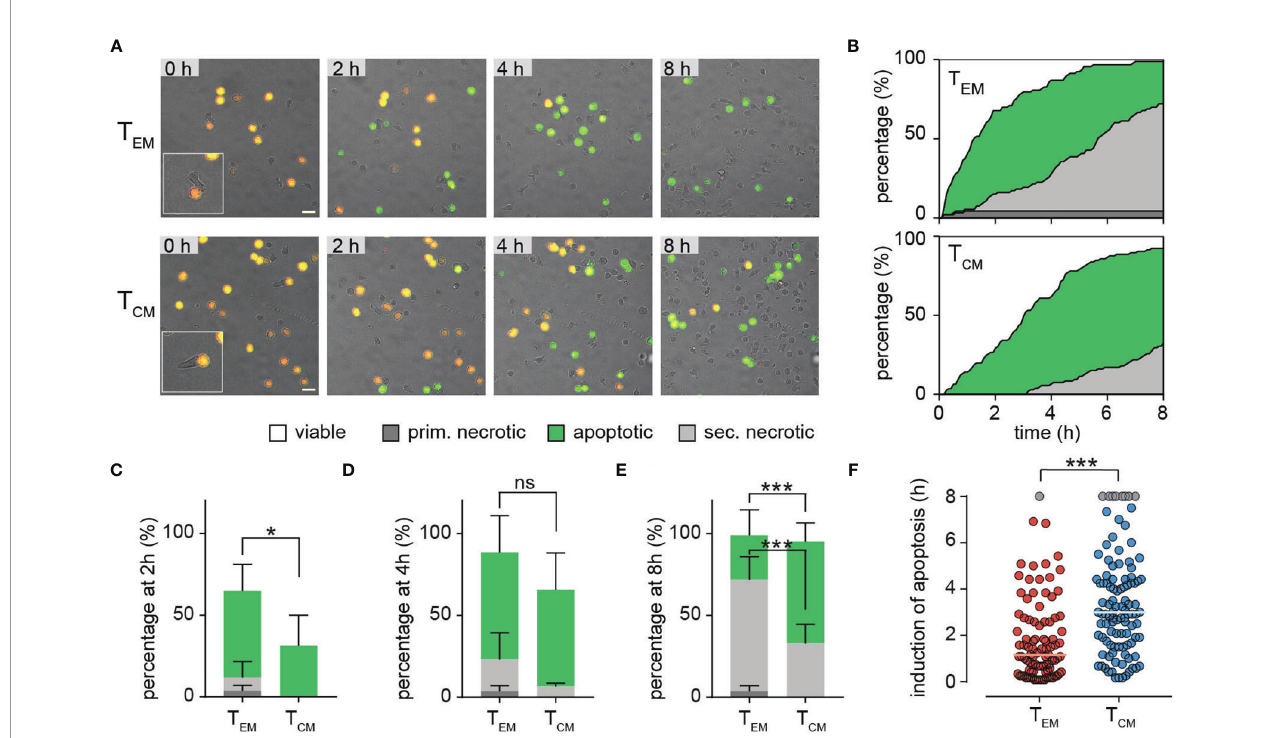
FIGURE 5 | Single cell level T EM and T CM analyses reveal distinct cytotoxic ef fi ciencies. (A, B) Sorted T EM and T CM were co-incubated with SEA-pulsed NALM6 pCasper cells at an E:T ratio of 2:1 for 8h to analyze cytotoxicity on single cell level. (A) Representative image section of T EM or T CM co-incubation. The insets illustrate the contact between T EM or T CM with the targets. Scale bars are 20 µm. (B) Quanti fi cation of target cell lysis events in a time resolved death plot showing the percentage of apoptotic target cells (green), primary necrotic target cell (dark grey), secondary necrotic target cell (light grey), necrotic/lysed (grey – for semi- automated analysis) or viable cells (white) by a manual analysis. (C-E) Quanti fi cation of target cell lysis at 2 (C) , 4 (D) or 8 (E) hours by manual analysis. Data are shown as mean +SD. (F) Single cell values of duration/time of apoptosis for each analyzed target cell. Cells showing no signs of caspase activity at 8 hours are shown in grey. Each point re fl ects the D t of apoptosis induction from a single target cell. The orange and blue lines represent the median. n=4 donors, T EM 94 cells, T CM 105 cells. Statistical analysis was done using a two-way ANOVA. *p<0.05; ***p<0.001; ns, no signi fi cant